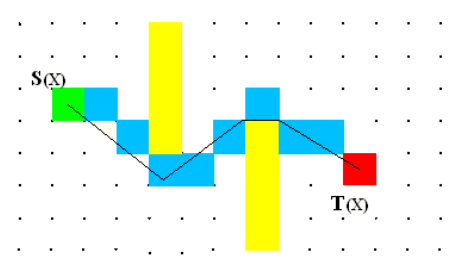
Figure 8. Result of path planning on robot.